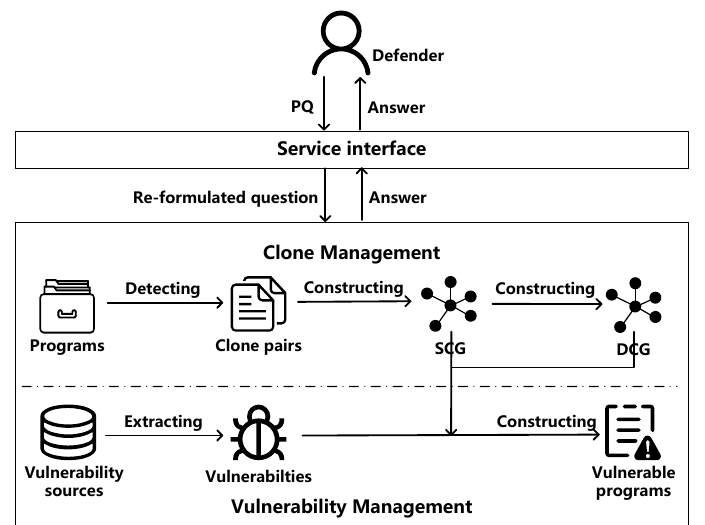
Figure 1. Overview of the CVMan